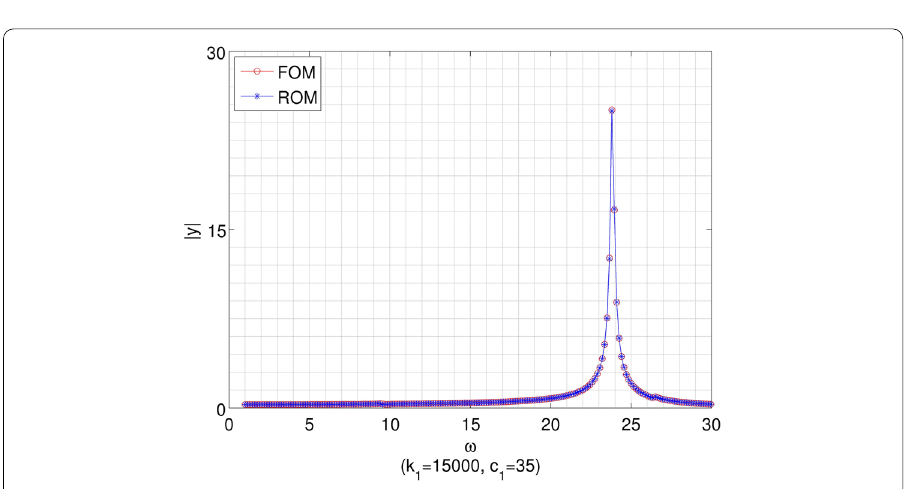
Fig. 13 The FRFs corresponding to the four interpolating points